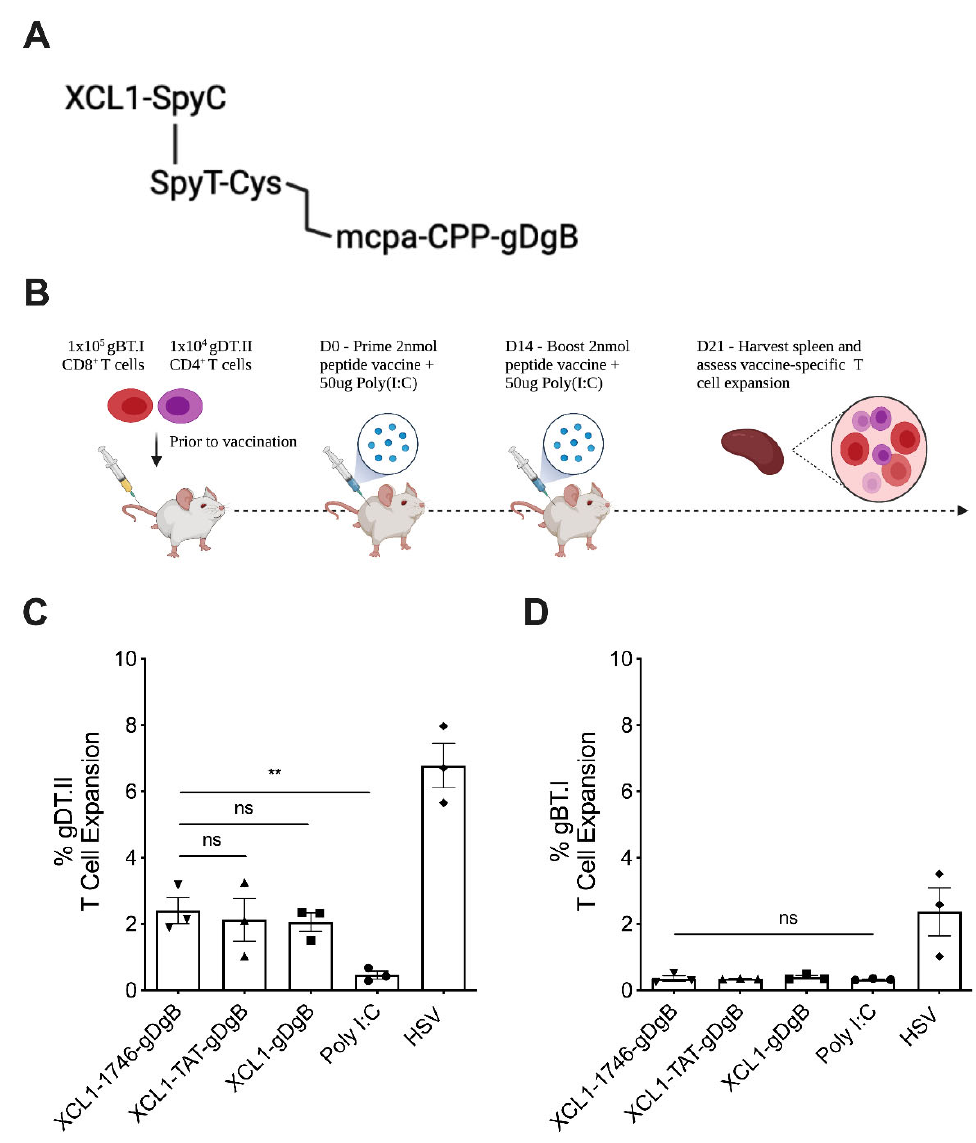
Figure 1. T cell expansion following prime-boost vaccination with XCL1-targeted, CPP-vaccines: ( A ) The peptide vaccine construct comprises an XCR1 targeting unit (XCL1-SpyC) linked to a vaccine unit (SpyT-Cys-Cys-CPP-gBgD). The disulphide linkage (Cys-Cys) should dissociate to release